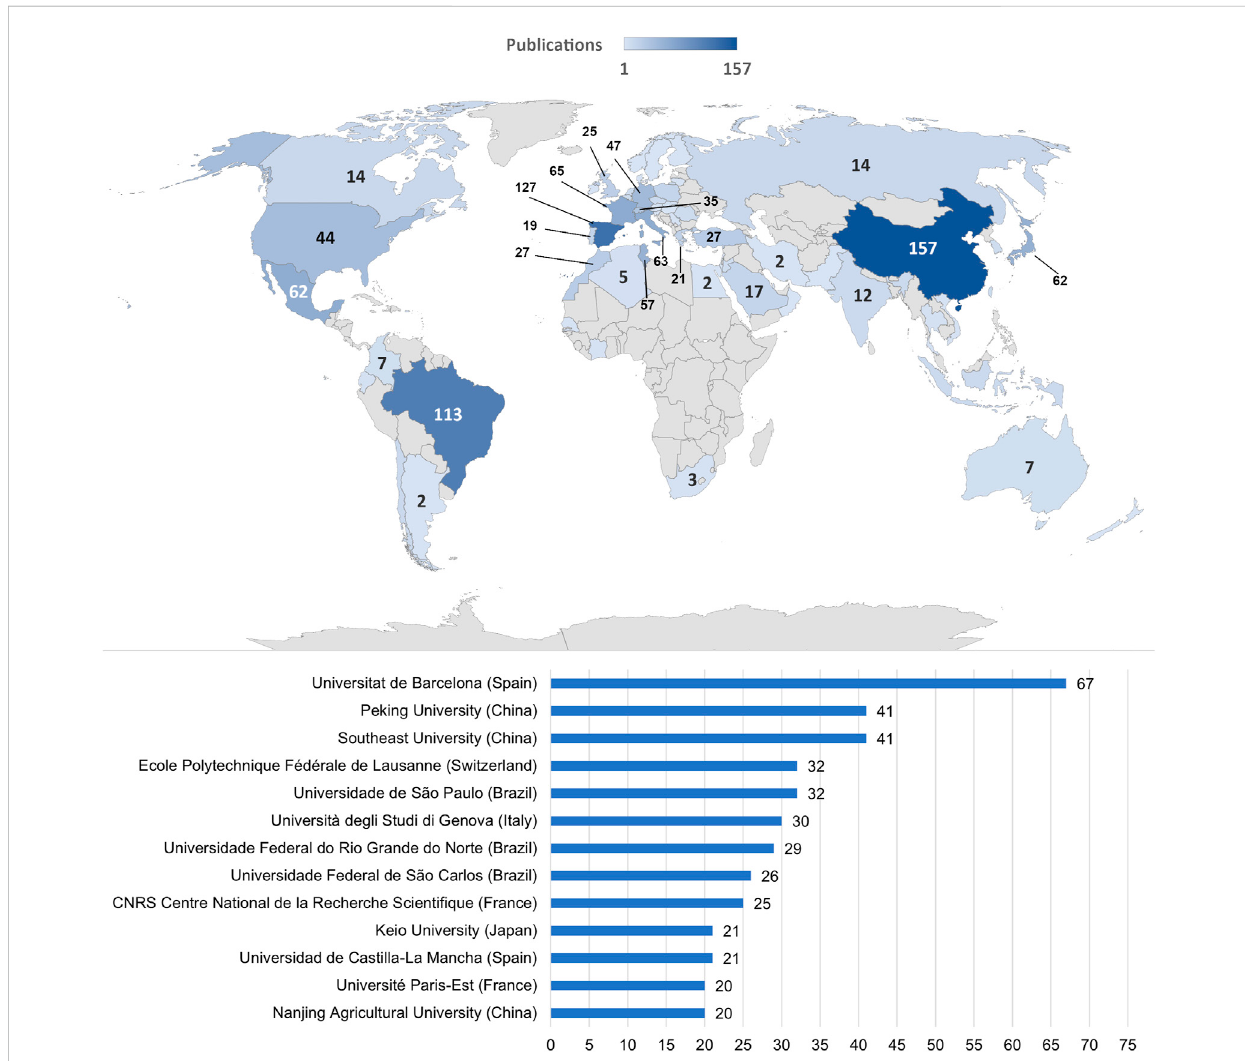
FIGURE 3 Number of publications per university and research center with more than 20 publications on BDD as an electrode for electrooxidation of contaminants (upper); and number of publications per country on BDD as an electrode for electrooxidation of contaminants (below). All results were based on the Scopus database (source: the